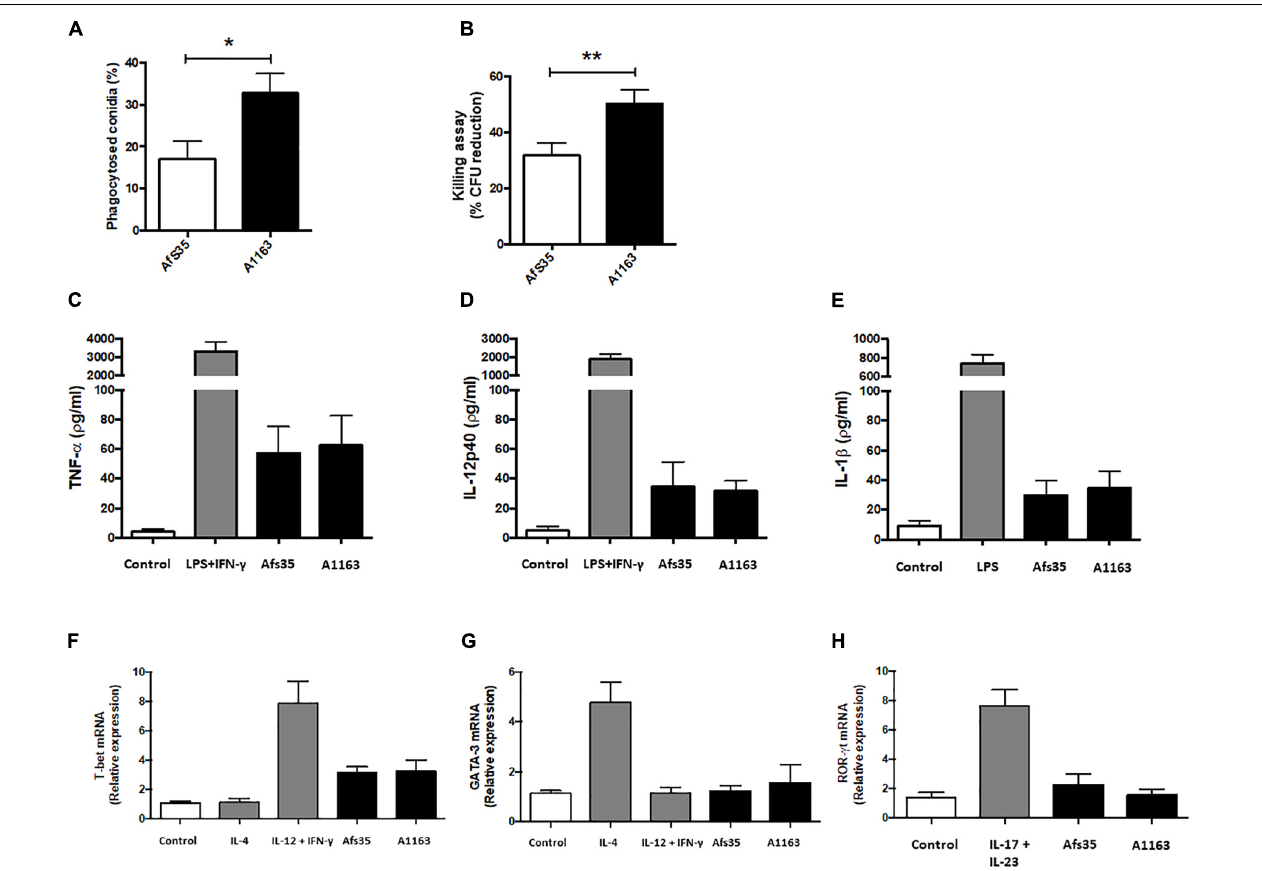
FIGURE 6 | Strain Afs35 is more resistant to in vitro macrophage-mediated killing than strain A1163 but does not elicit a different immunological response. Bone marrow-derived macrophages (BMDMs) were obtained from C57BL/6 adult mice. Phagocytosis index (A) and killing activity (B) is increased in strain A1163 when statistically compared to strain Afs35. To evaluate the level of relevant cytokines, BMDMs were incubated with culture medium, LPS (lipopolysaccharides) + INF γ , and A. fumigatus strains Afs35 or A1163. The supernatants were assayed for TNF- α (C) , IL-12p40 (D) , and IL-1 β (E) levels and comparisons were made between the control condition and both strains. The levels of relative mRNA expression of T-bet (F) , GATA-3 (G) , and ROR- γ t (H) were determined by real-time PCR, using the β -actin gene as a control comparing the control condition with both strains. The results represent the mean ± SD (standard deviation) from three independent biological replicates. ∗ p < 0.05, ∗∗ p < 0.005 from an unpaired, equal variance student’s t -test, with strain Afs35 compared to strain A1163 (A,B) , or from a one-way ANOVA test with multiple comparisons (C–H)